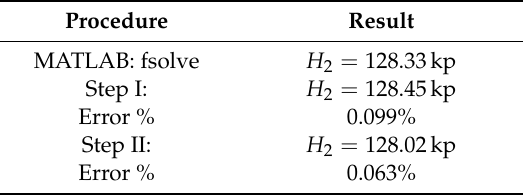
Table 3. Results for the cable RZ 3x50 Al / 54.6 Alm .